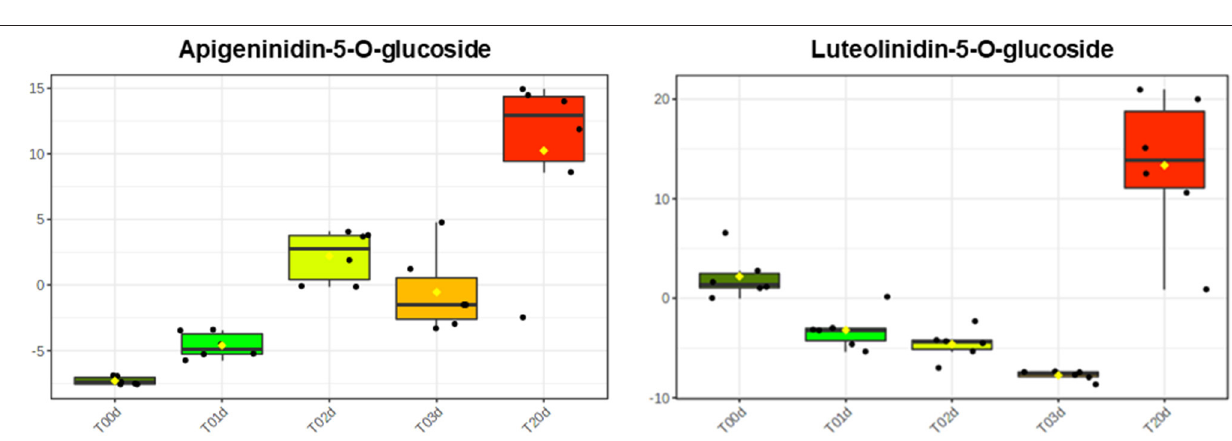
FIGURE 6 | Different levels of the 3 deoxyanthoacynidins apigeninidin 5- O -glucoside and luetolinidin 5- O - glucoside in A. filiculoides challenged with 5 ◦ C and moderate light intensity for 20